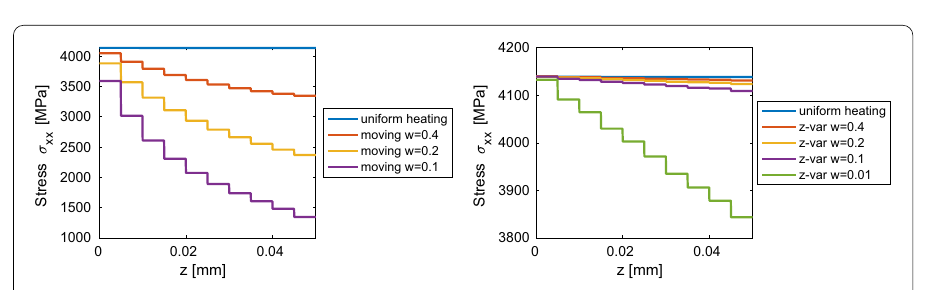
Fig. 10 Two-dimensional example: residual stress distribution σ xx after subjecting domain to a uniform (first row) or moving (second to fourth row) peak temperature profile